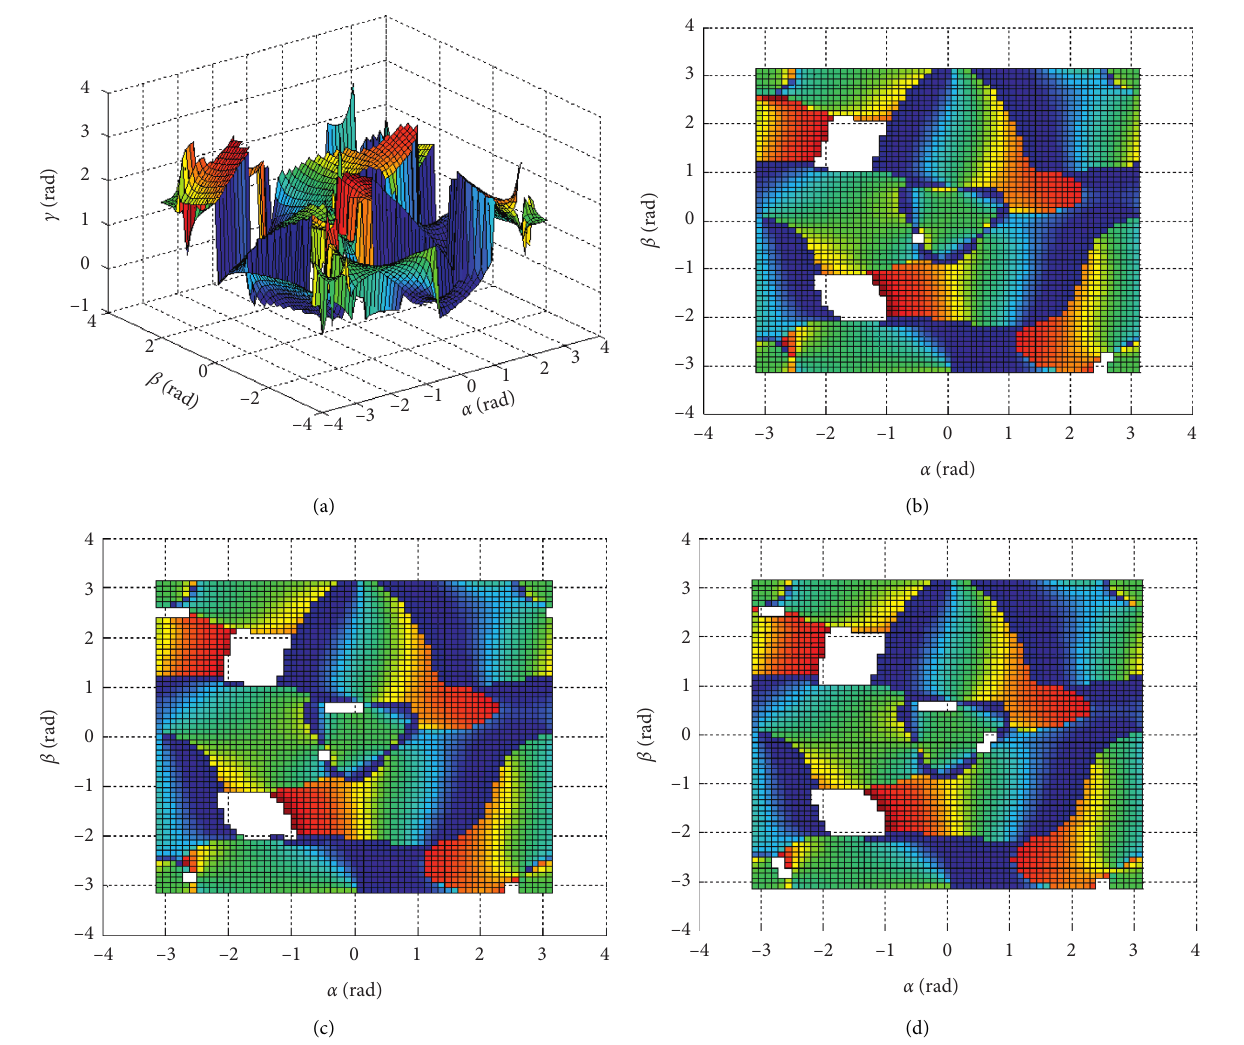
Figure 12: The singularity locus with different positions. (a) (( X ) � 9.5, ( Y ) � ( Z ) � 0), (b) (( X ) � − 4.9, ( Y ) � − 14.4, ( Z ) � 0), (c) (( X ) �− 19.2, ( Y ) � (Z) � 0), (d) (( X ) �− 4.9, ( Y ) � 14.4, ( Z ) �